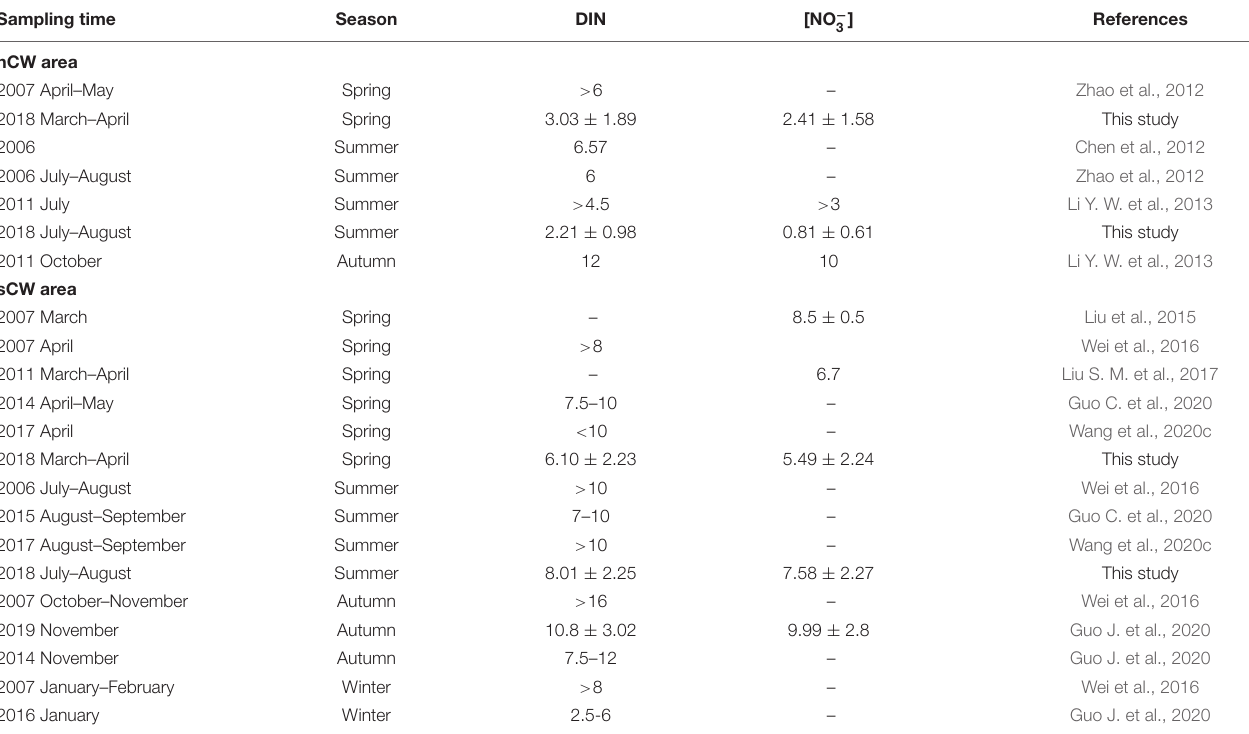
TABLE 2 | Comparison of DIN and nitrate concentration ( µ mol L − 1 ) in the nCW and sCW areas. Sampling time Season DIN [NO −